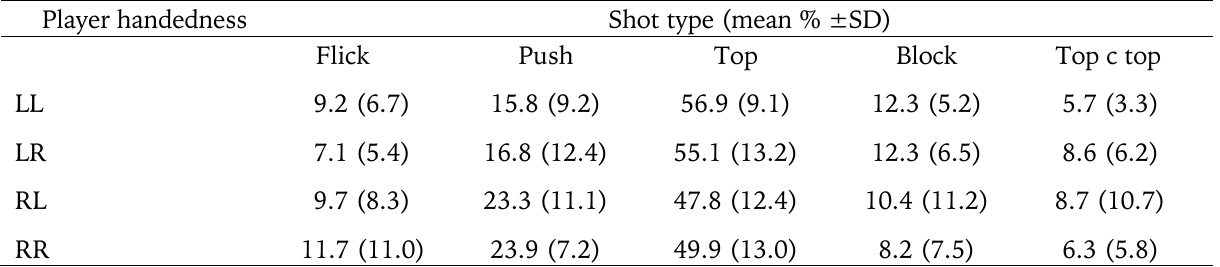
Type of shot distribution of S3 in relation to serving and receiving player’s handedness.